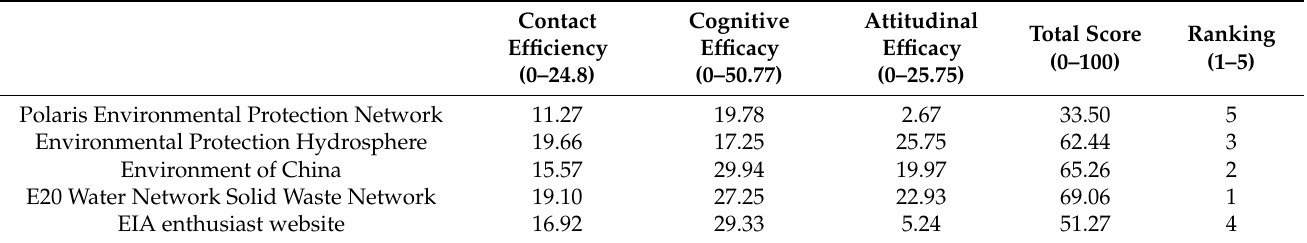
Table 7. Overall score and ranking of official account communication efficiency based on ideological and political